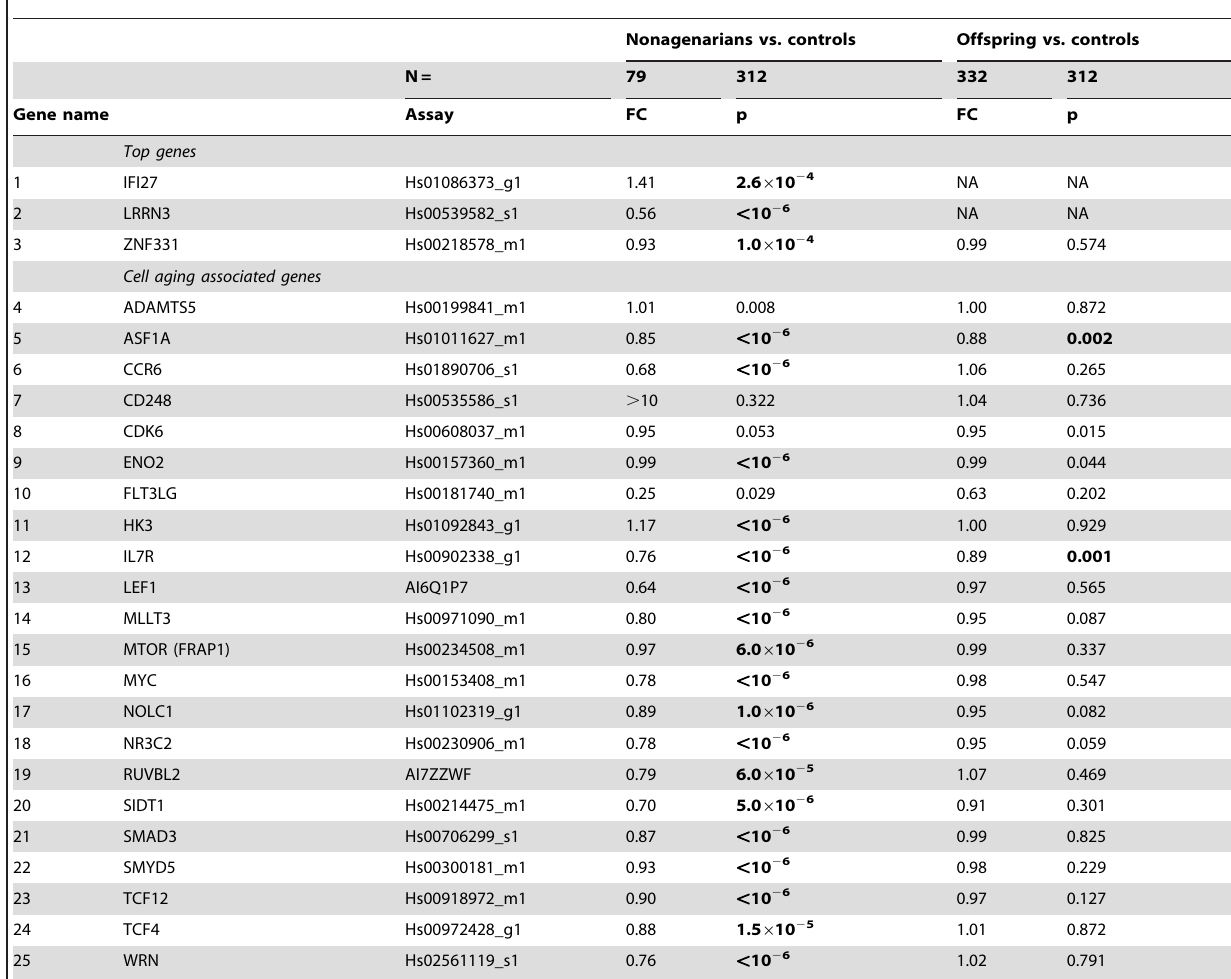
Table 2. RT-qPCR results.